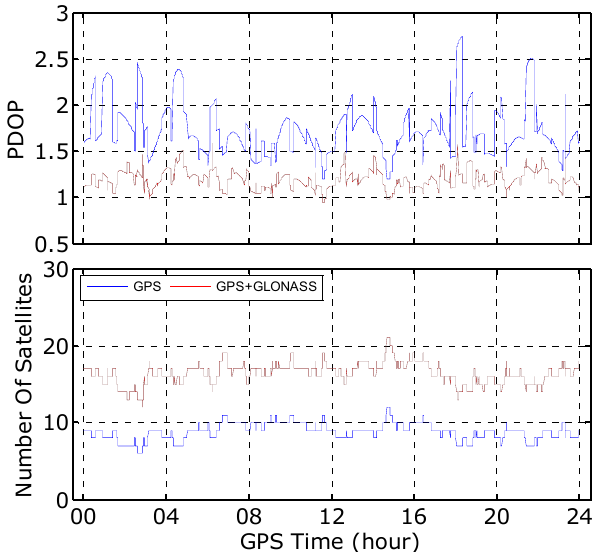
Figure 2. Satellite number and PDOP (position dilution of precision) values for Global Positioning System (GPS) only and GPS+Globalnaya Navigatsionnaya Sputnikovaya Sistema (GLONASS) at one station (TUBO) in the center of the network on day of year 001 in 2013. Table 1. Technical details of the 20 tracking stations used with various hardware configurations.